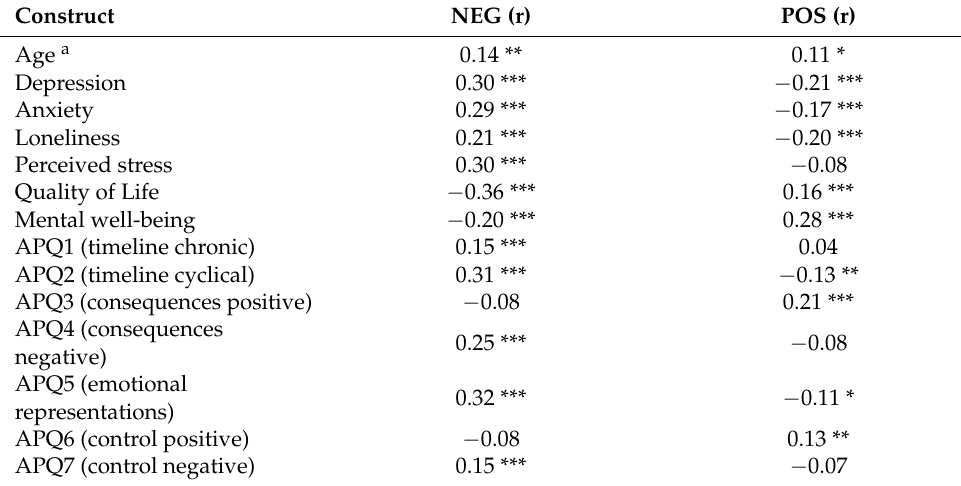
Table 6. Pearson’s correlation coefficients for the relationship between perceived negative (NEG) and positive (POS) ageism subscales and variables of